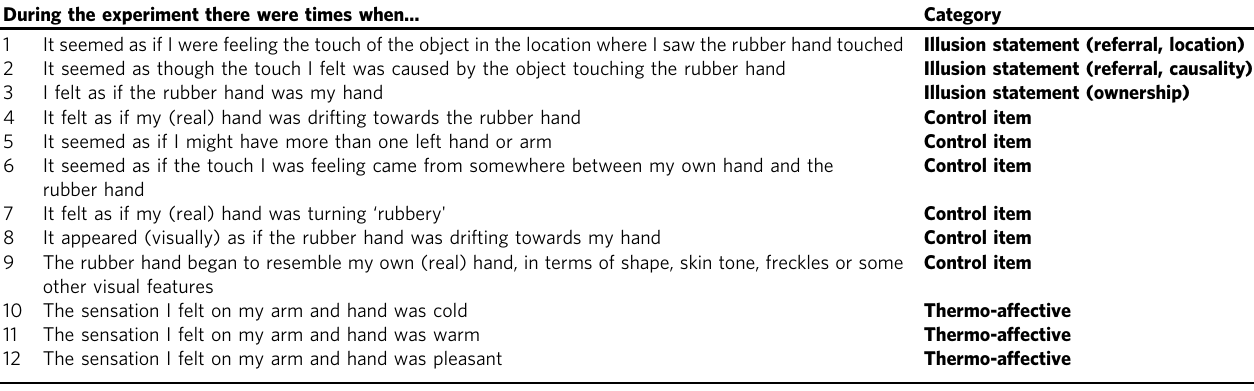
Table 1 Illusion questionnaire, with the classic illusion statements, the control, and thermo-affective items (speci fi ed in bold). During the experiment there were times when